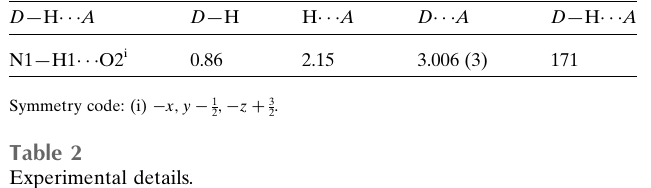
Table 1 Hydrogen-bond geometry (A˚ , (cid:2) ).